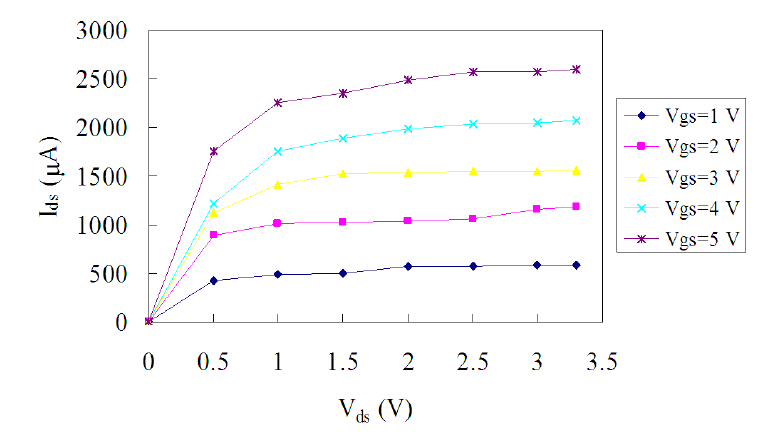
/V characteristics for the FET pressure ds ds